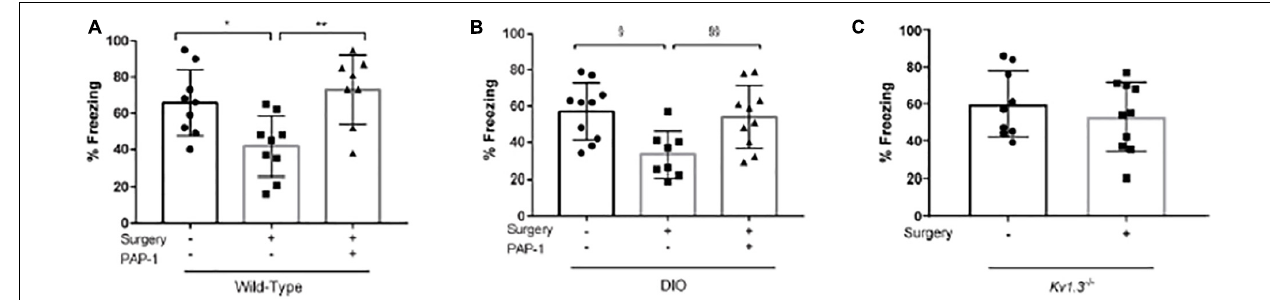
FIGURE 3 | Role of Kv1.3 in postoperative cognitive decline in the trace fear-conditioning (TFC) paradigm. Applied for Permission to Reproduce Ieng et al. (2020). Cohorts of mice were trained in a TFC paradigm immediately before surgery and tested for freezing behavior 3 days after surgery. (A) Wild-type mice (12-14 weeks old C57bl/6j) were randomized to three groups ( n = 8–9 per group) that received no surgery/vehicle, surgery/vehicle, or surgery/phenoxyalkoxypsoralen-1 (PAP-1). (B) Wild-type mice with diet-induced obesity (DIO) were randomized to three groups ( n = 8–10 per group) that received no surgery/vehicle, surgery/vehicle, or surgery/PAP-1. (C) Mice deficient in Kv1.3 (Kv1.3–/–) were randomized to two groups ( n = 910 per group) that received either sham (no surgery) or surgery. After wound closure and every 12 h thereafter, the mice randomized to PAP-1 received 40 mg kg 1 i.p. vehicle consisted of MIGLYOL in the same volume as PAP-1. On the third day, freezing behavior was tested in the same context as the training. (A,B) Analyzed by one-way analysis of variance followed by Bonferroni post hoc test. (C) Analyzed by unpaired t -test. *P1/40.029; **P1/40.005; xP1/40.011; xxP1/40.030 (Ieng et al., 2020).